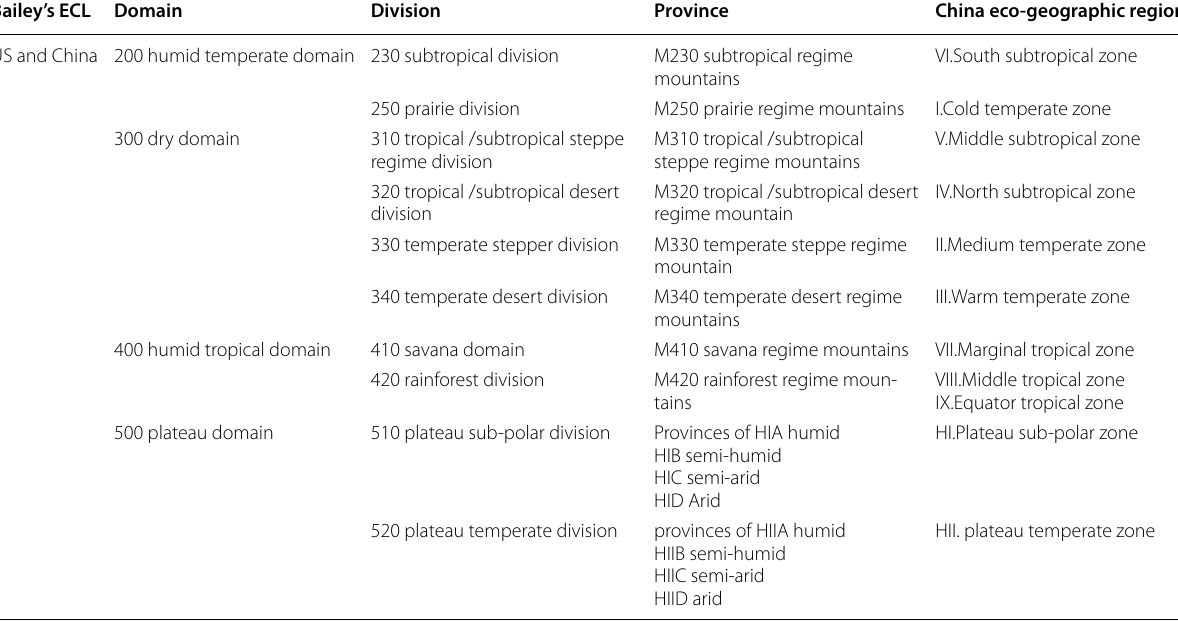
Table.1 Comparing and assessing upper levels of China’s and Bailey’s ECL Bailey’s ECL